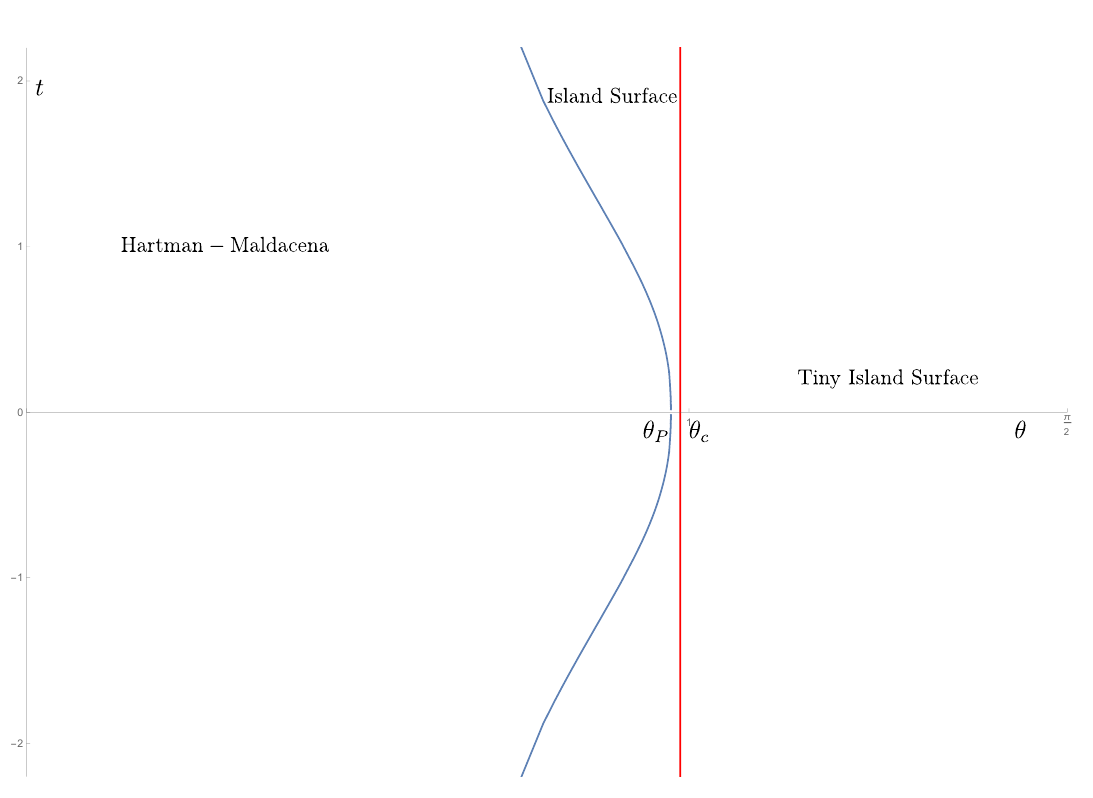
Figure 7: A phase diagram for d = 4 showing the dominant minimal surface as a function of time t and the larger brane-angle θ . The transition between the island surface and the tiny island surface always takes place across the critical angle. The transition between the Hartman-Maldacena surface and the island surface is across the blue curve, which intersects t = 0 at the Page